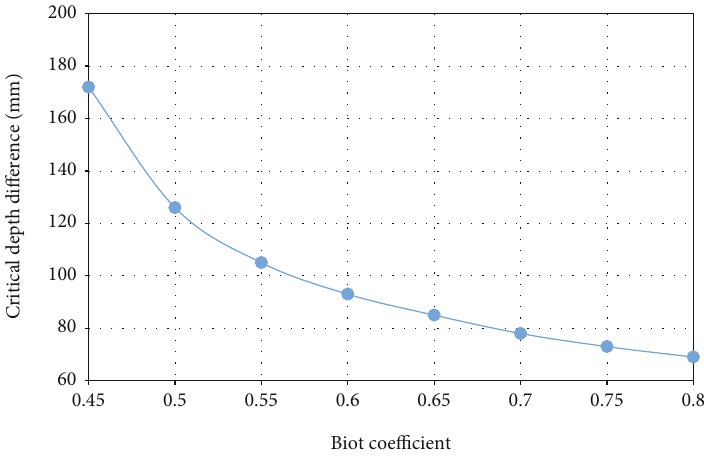
Figure 18: Critical depth di ff erence with di ff erent Biot coe ffi